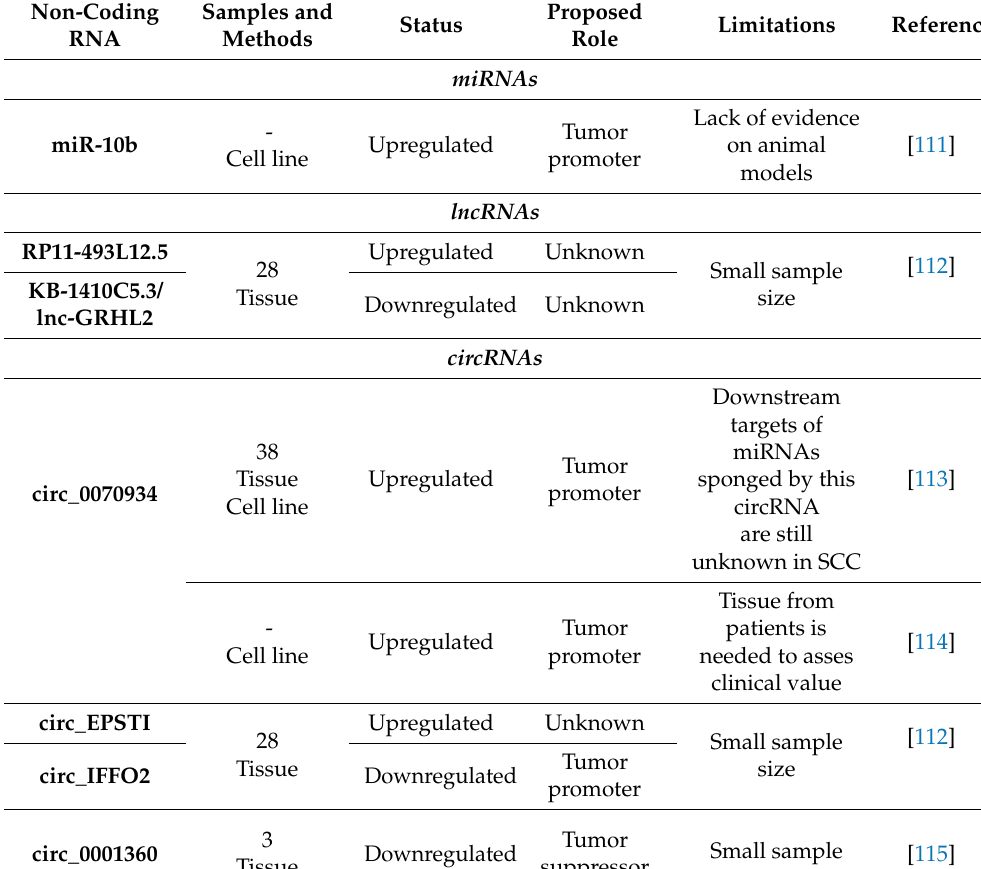
Table 4. Non-coding RNAs implicated in